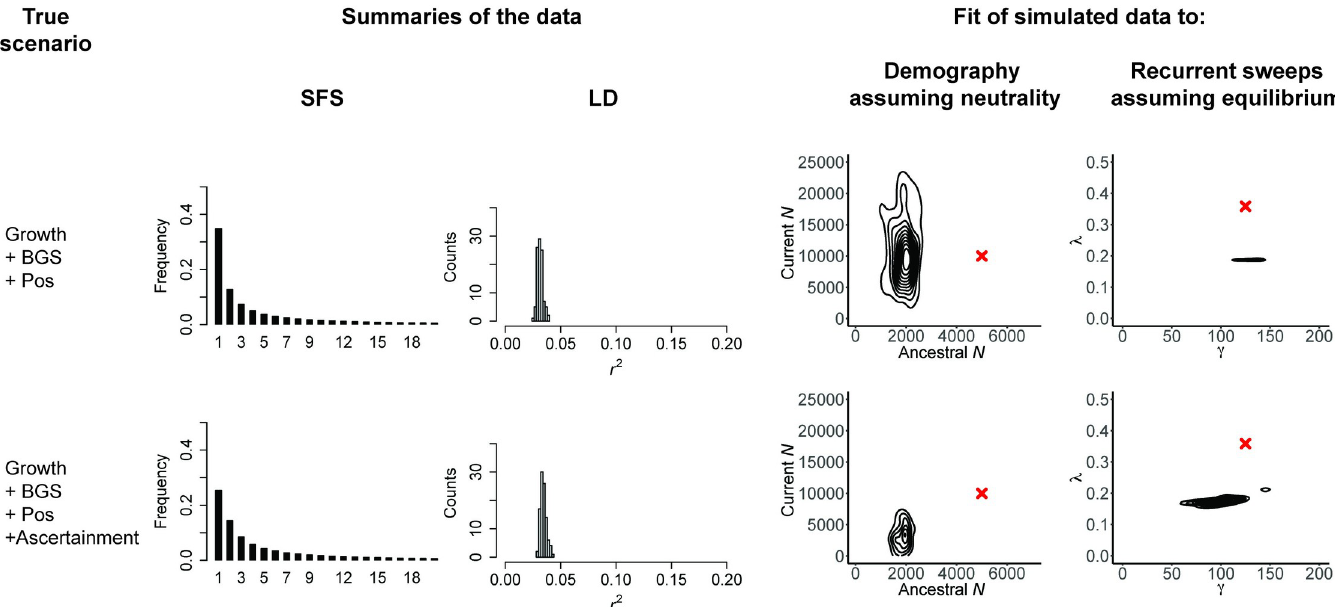
Fig 2. Ascertainment errors may amplify mis-inference, if not corrected. As in Fig 1, the scenarios are given in the first column, here population growth with background selection and recurrent selective sweeps (“Growth + BGS + Pos”), as well as the same scenario in which the imperfections of the variant-calling processes are taken into account—in this case, one-third of singletons are not called (“Growth + BGS + Pos + Ascertainment”). The middle columns present the resulting SFS and LD distributions, and the final columns provide the joint posterior distributions when the data are fit to 2 incorrect models: a demographic model that assumes strict neutrality and a recurrent selective sweep model that assumes a constant population size. All exonic (i.e., directly selected) sites were masked prior to analysis. Red crosses indicate the true values. As shown, unaccounted for ascertainment errors may contribute to mis-inference. The scripts underlying this figure may be found at https:// github.com/paruljohri/Perspective_Statistical_Inference/tree/main/SimulationsTestSet/Figure2. LD, linkage disequilibrium; SFS, site frequency spectrum.